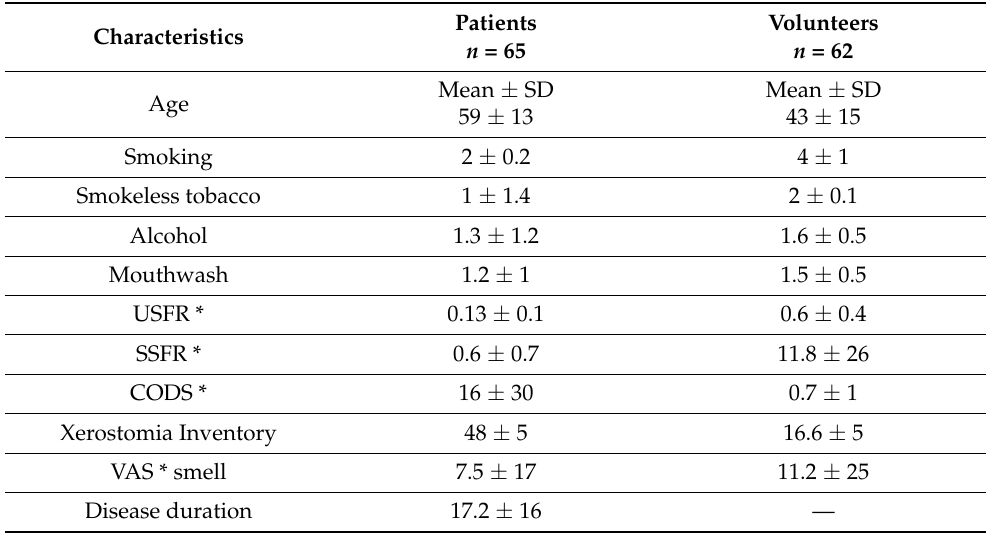
Table 1. Characteristics of patients and healthy